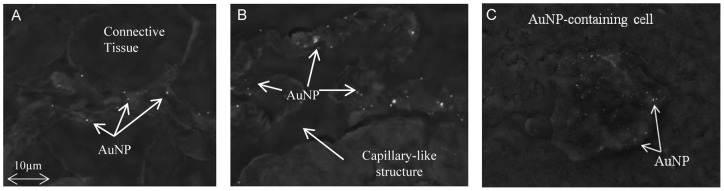
AuNP distribution within mouse liver following IP injection.AuNPs in (A) the liver connective tissue and (B) a 5 µm capillary within the liver adipose tissue (Mag 5.00K x), and in (C) a Kupffer cell within the sinusoid of the liver (Mag 4.19K x).